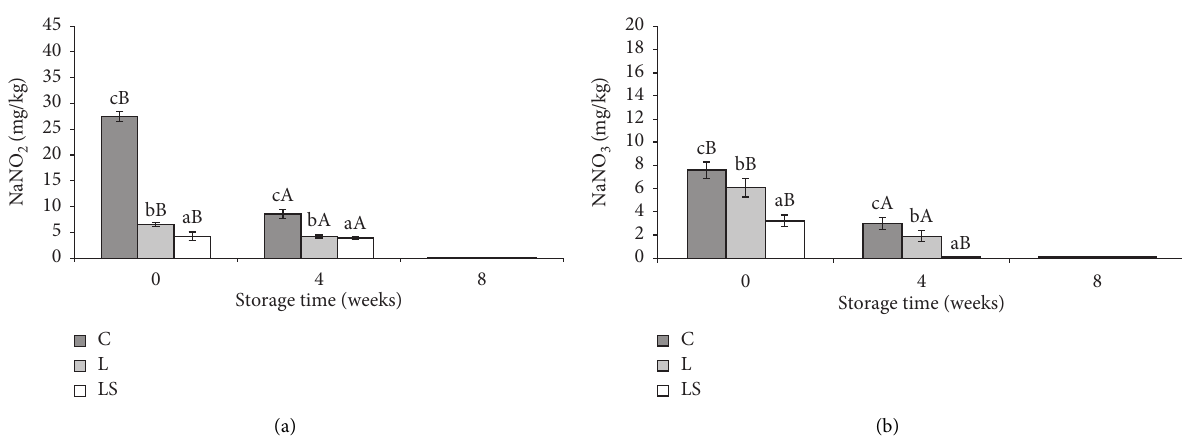
Figure 1: The content of nitrites (a) and nitrates (b) in model products. The figure shows mean values (bars) and standard deviation error (line segments). Mean values denoted by different capital letters (A, B) within the same sample and by small letters (a–c) among different samples differ statistically significantly ( P ≤ 0 . 05). C: control treatment, quantity added NaNO 2 100mg/kg; L: quantity added NaNO 2 —15mg/kg; LS: quantity added NaNO 2 —15mg/kg + S. carnosus ATCC 51365 in number 10 7 cfu/g. Table 3: The influence of storage times on the colour parameters ( L ∗ ,a ∗ ,b ∗ , h ° , C ∗ , Δ E ∗ ) of the model meat products (mean- s ± standard deviation error).